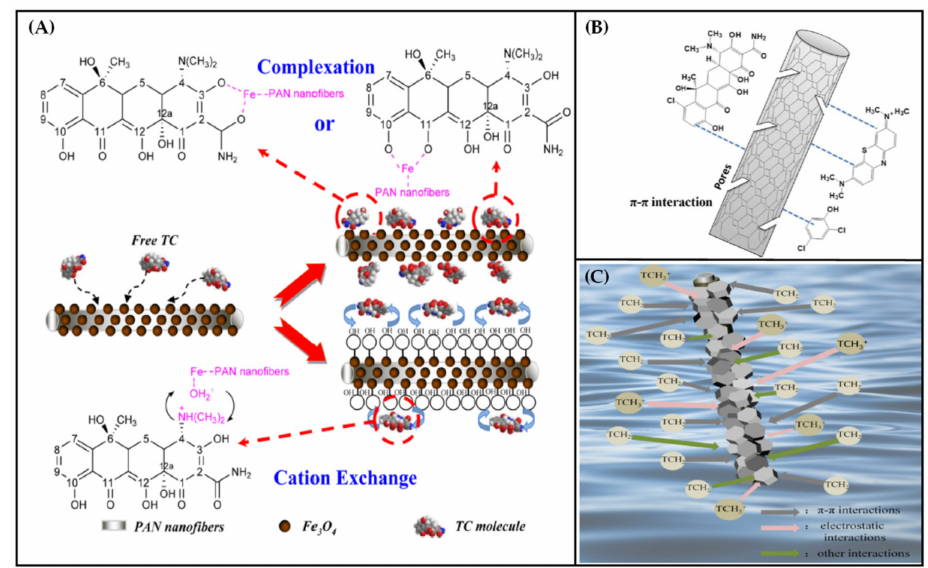
Figure 10. ( A ) Adsorption mechanism of TC on Fe 3 O 4 /PAN composite nanofiber membrane [130]; ( B ) adsorption mechanism diagram of TC, 2,4-DCP, MB on PI-based carbon nanofiber membrane [131] and ( C ) adsorption mechanism diagram of TC on ZIF-8/PDA/PAN nanofiber membrane